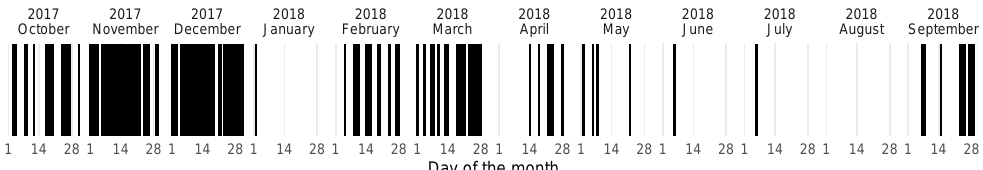
Figure 2. Overview of days identified as valley wind days (VWDs) during the observational period. Black columns indicate VWDs. Months are indicated above the